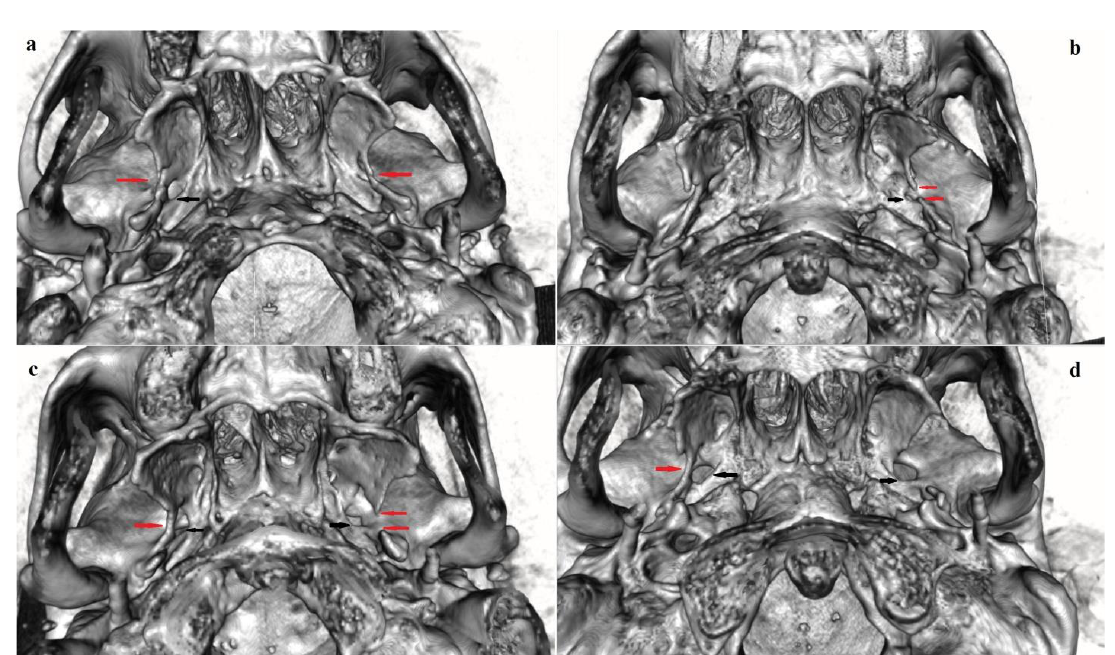
Figure 2. Pterygospinous bridge: ( a ) a bilateral complete PsB, enclosing PsF; ( b , c ) a complete PsB on the right side and an incomplete PsB on the left side; ( d ) an unilateral (right-sided) complete PsB. Designations: red arrows point to PsBs; black arrows point to foramen ovale. Abbreviation: